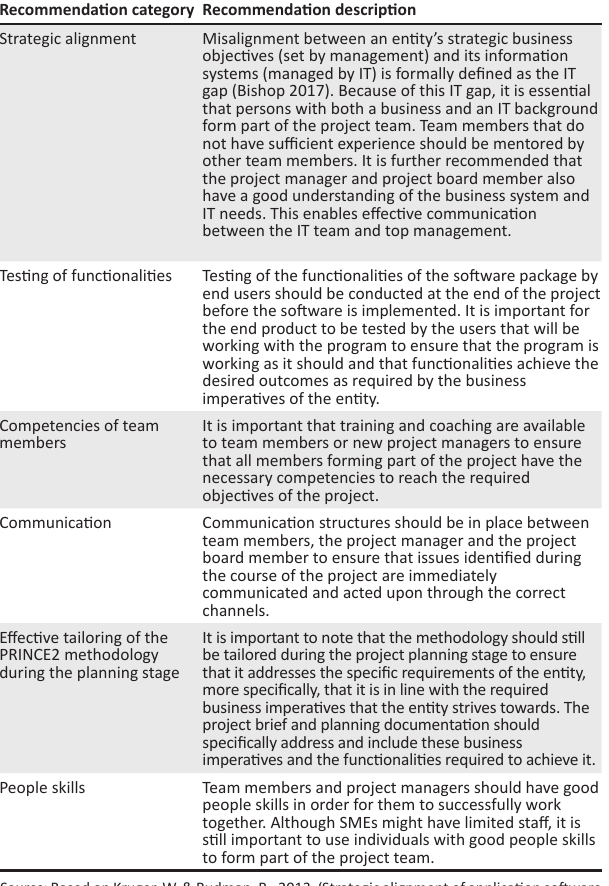
TABLE 3: Recommendations for addressing shortcomings and weaknesses of Projects in Controlled Environments.